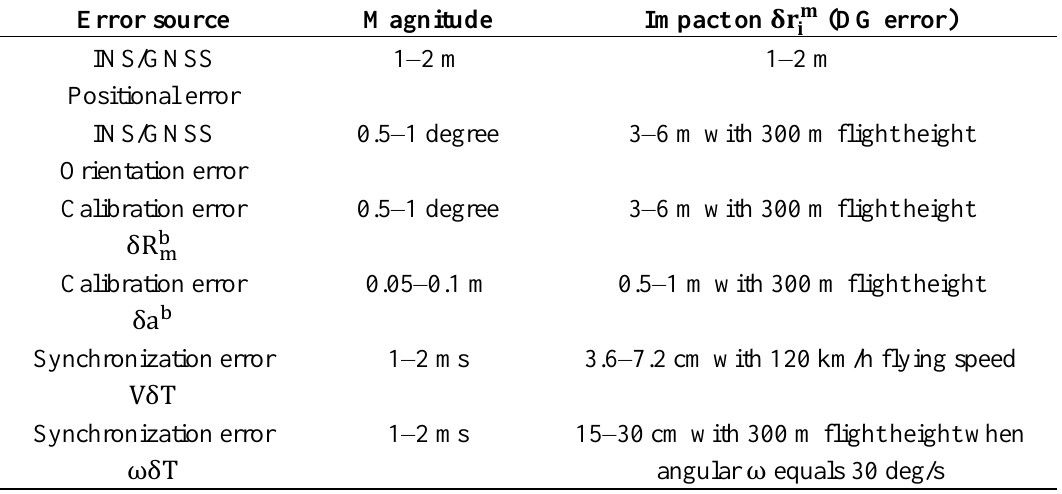
Table 7. Error budgets of the proposed